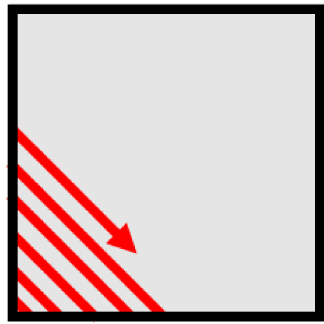
Figure 3. L-PBF zig-zag scanning pattern at 45 ◦